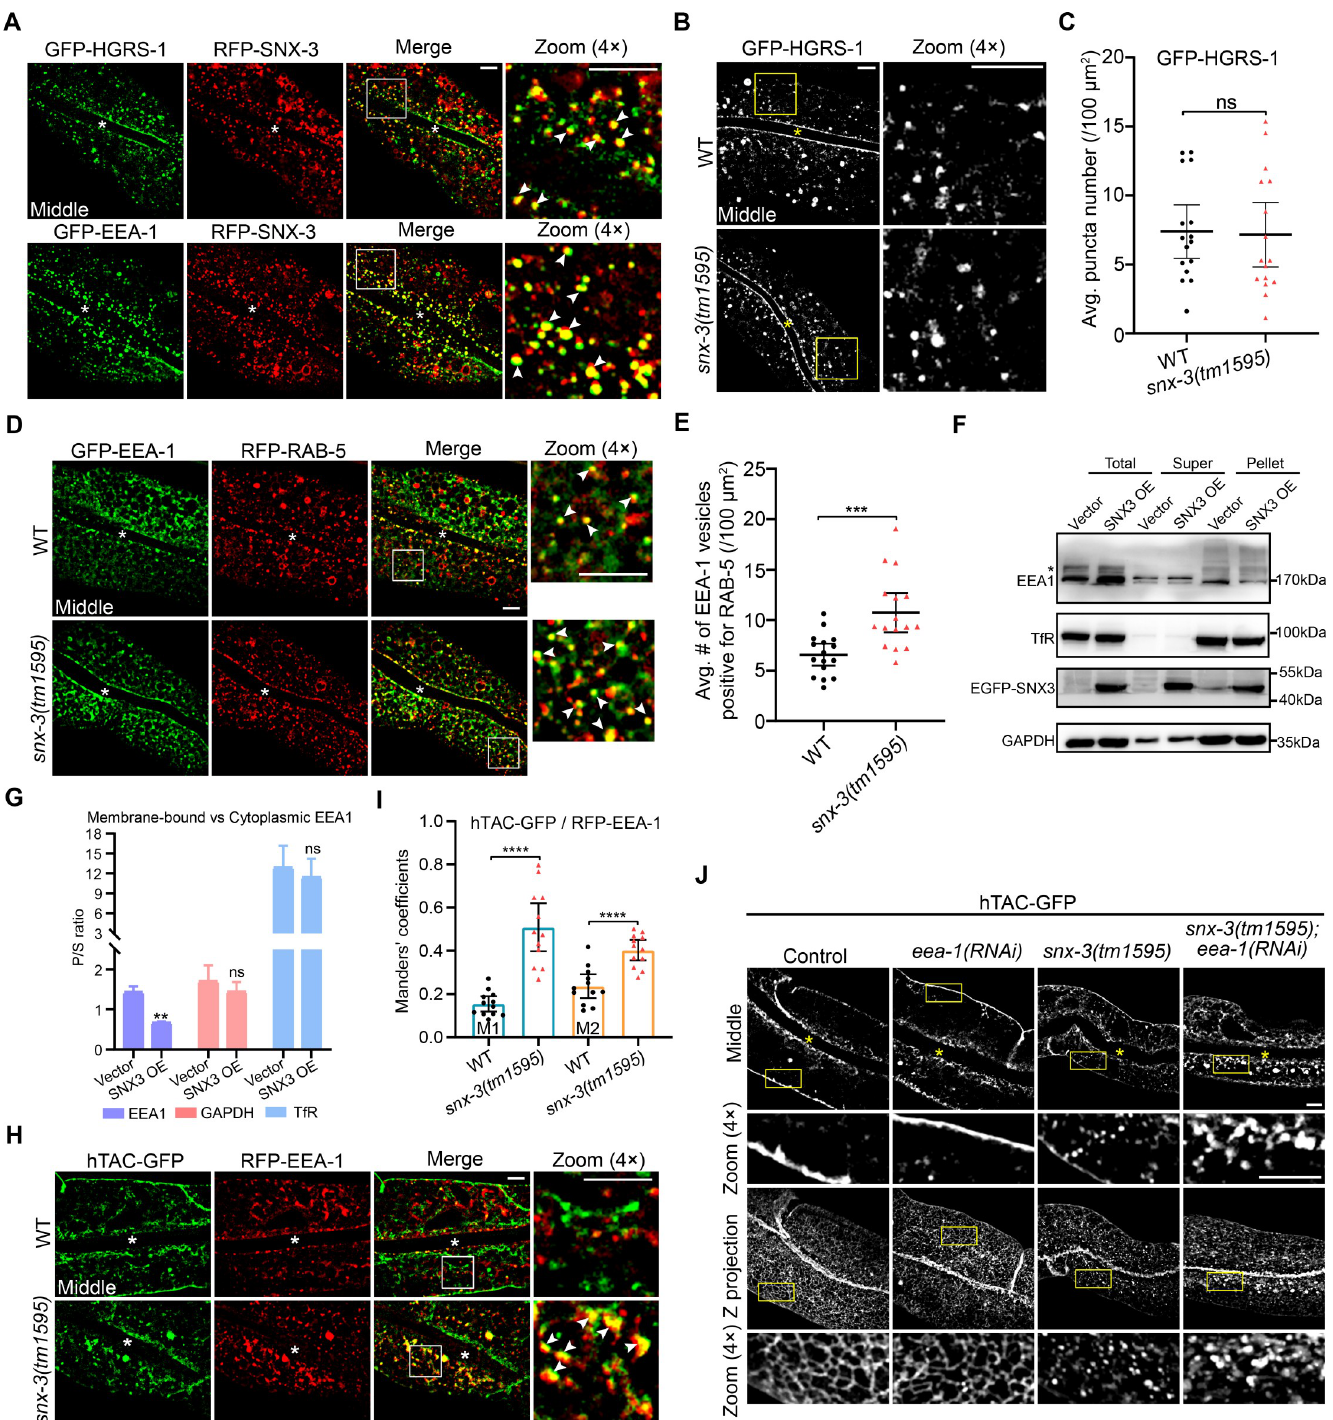
Fig 6. SNX-3-mediated CIE recycling tubules do not converge into the classical EEA-1-labeled sorting endosomes. (A) Micrographs showing RFP-SNX-3 partially overlapped with GFP-tagged HGRS-1 or EEA-1. (B,C) Confocal images (B) and quantification of the number of GFP-HGRS-1 signals (C) show no impact on GFP-HGRS-1 in snx-3(tm1595) mutants. [ROI] = 16, n = 12. Error bars are mean ± 95% CI. ns, not significant (Student’s t test). (D) Confocal images showing the overlap of GFP-EEA-1 and RFP-RAB-5 in WT and snx-3(tm1595) mutant animals. (E) Quantification of the number of RFP-RAB-5-positive GFP-EEA-1 vesicles for each genotypes as indicated in D. Error bars are mean ± 95% CI ([ROI] = 16, n = 12). ��� P < 0.001 ( t test with Welch’s correction). (F,G) The membrane-to-cytosol ratio of EEA1 decreased in SNX3-overexpressed Hela cells. Hela cells overexpressing empty or EGFP-SNX3 vector were separated into a supernatant (S) fraction and a